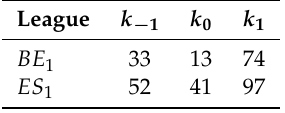
Table 1. Combined measure of home advantage in the 2016/2017 season—observed counts.